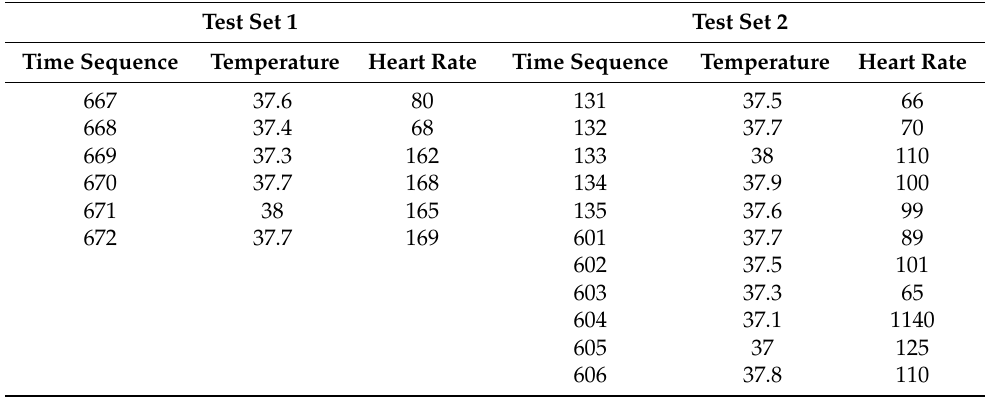
Table 1. The unhealthy biomedical signal in test